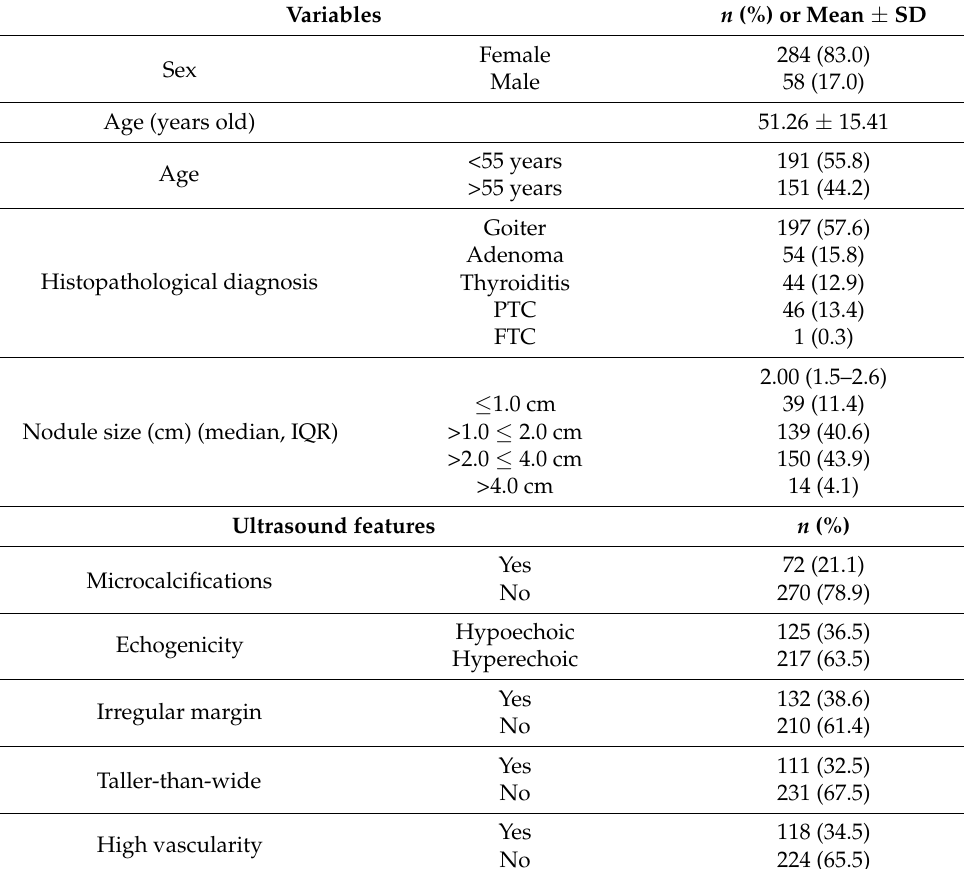
Table 1. Demographic and clinical characteristics and ultrasound features of 342 patients with AUS/FLUS diagnosis after first